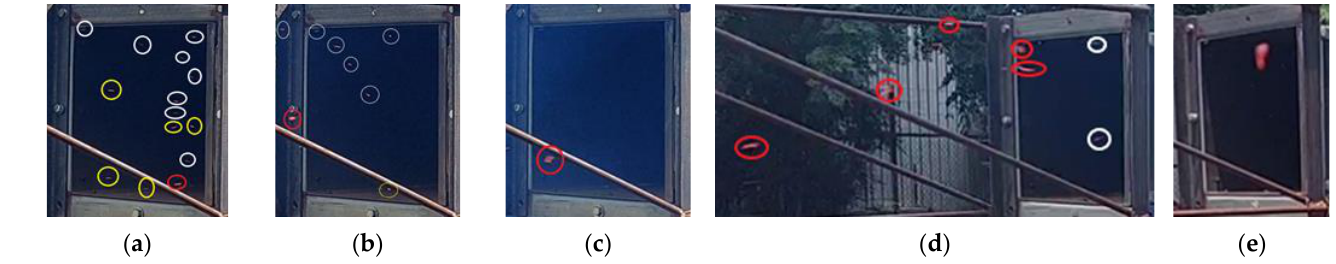
Figure 17. Firebrands at the exit of the wind tunnel. White, yellow and red circles show quenched, almost quenched and glowing firebrands. All photos taken with a camera set for a shutter speed of 4 milliseconds. The mesh was placed in the test section for ( a – c ) and no mesh was used for ( d , e ).